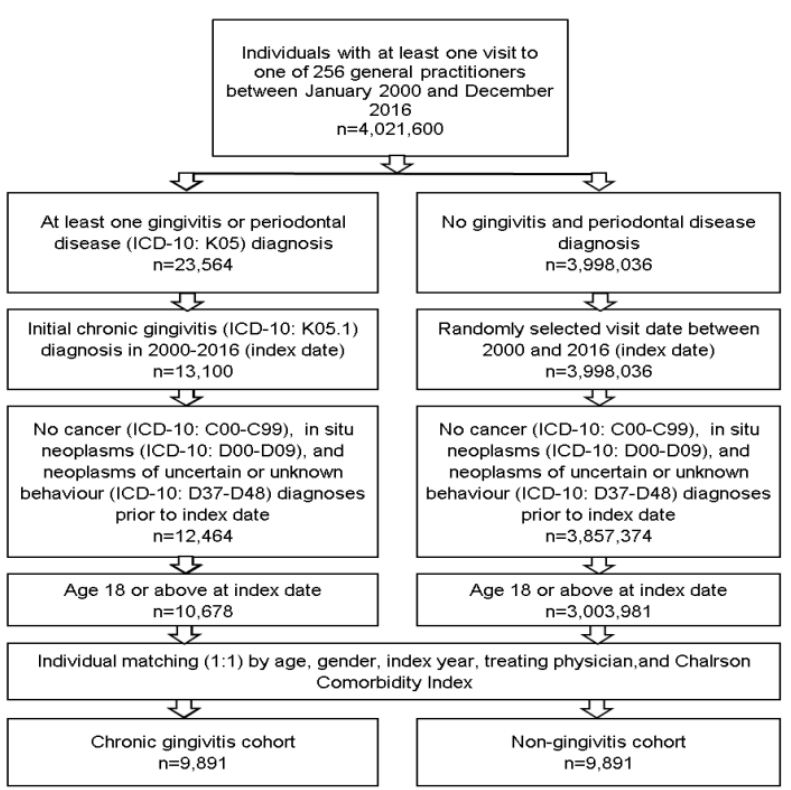
Figure 1. Selection of study patients.